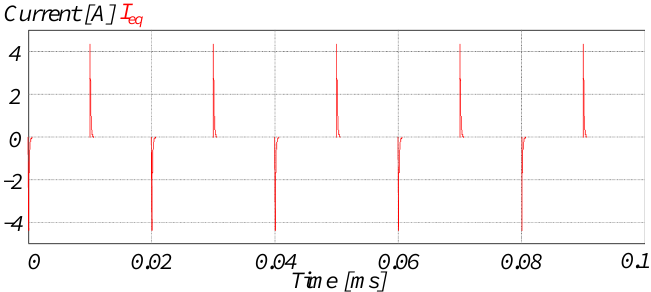
Figure 19. Zoom of the equalization current of the classic capacitor-based